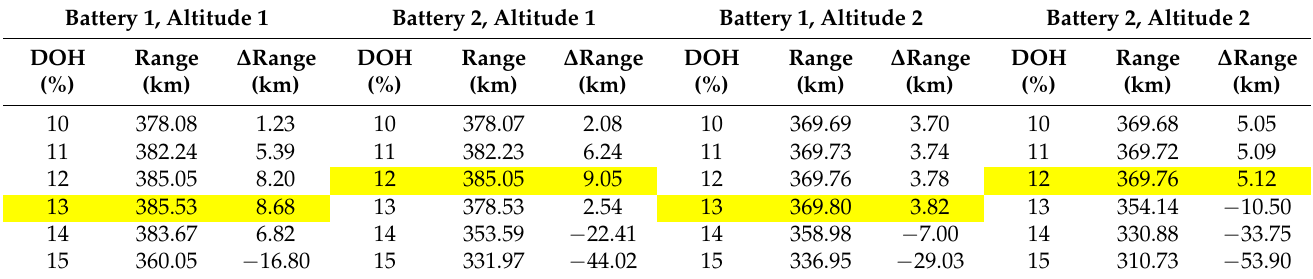
Table 4. Total mission hybridization simulation results compared to 30% DOH ICE-only cruise